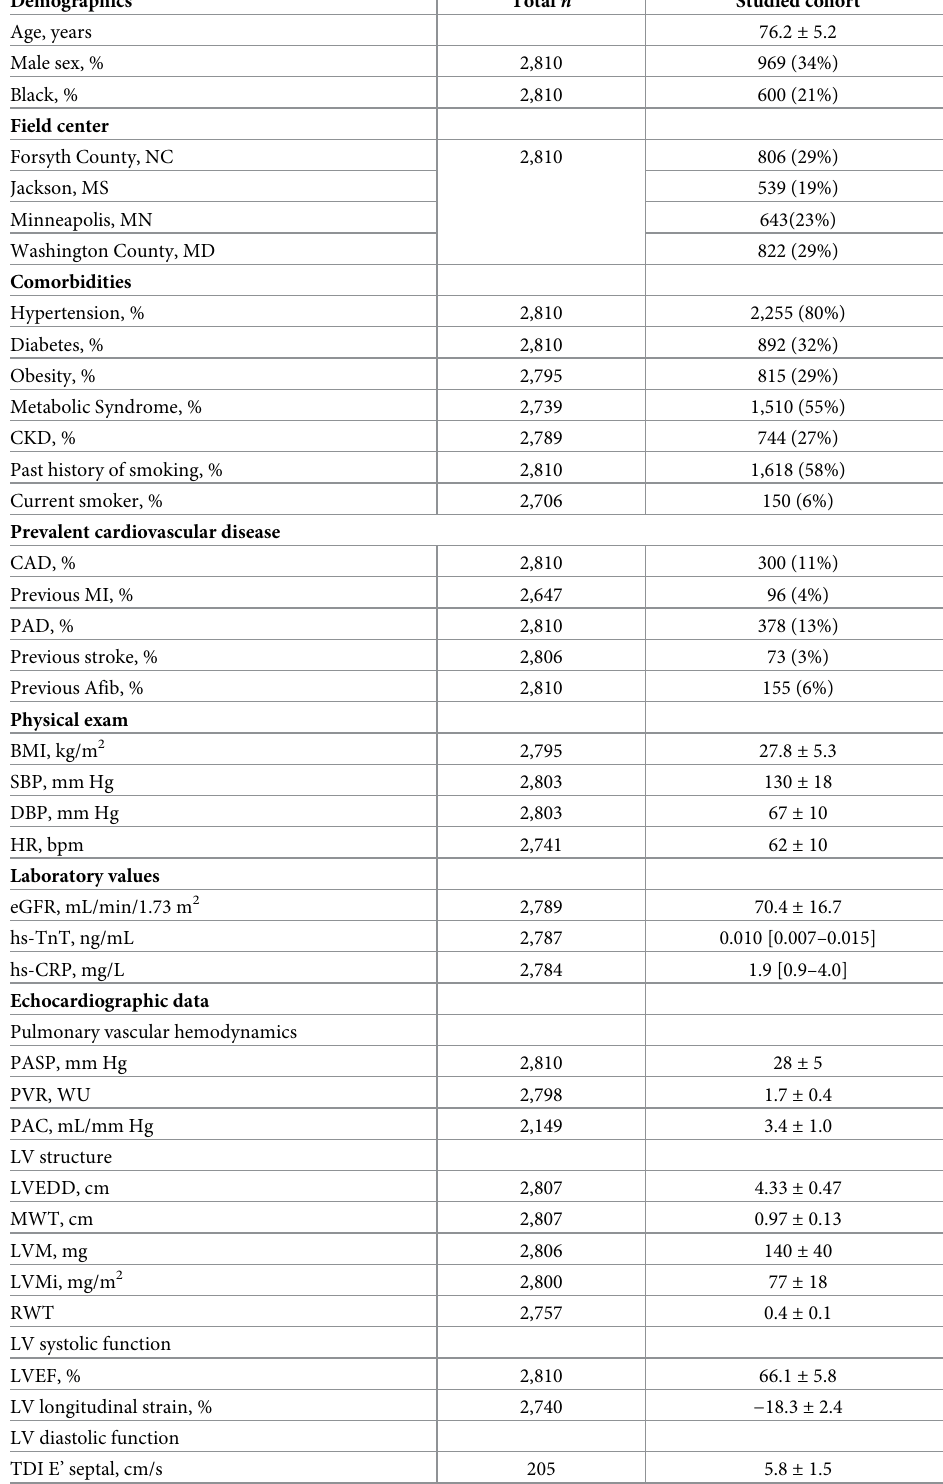
Table 1. Clinical characteristics and echocardiographic features of the study